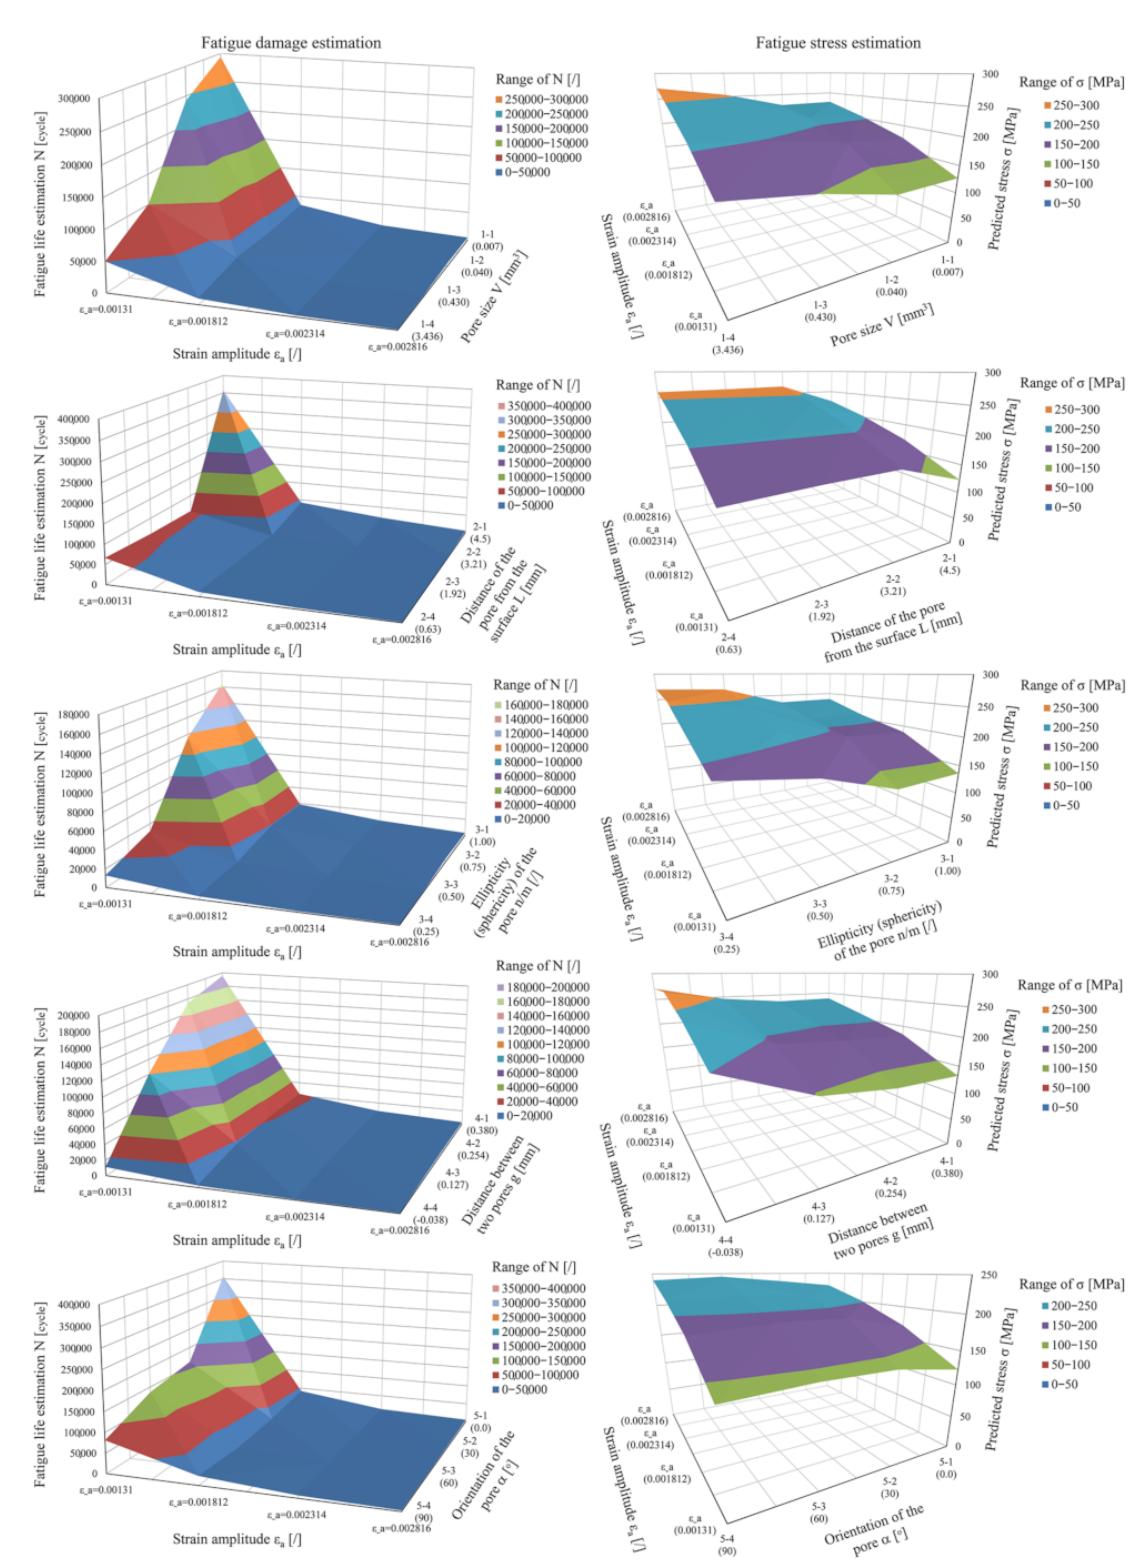
Figure 9. Distribution of fatigue lives N ( left ) and stress concentrations σ ( right ) as a function of the geometric influences of porosity and strain ε a